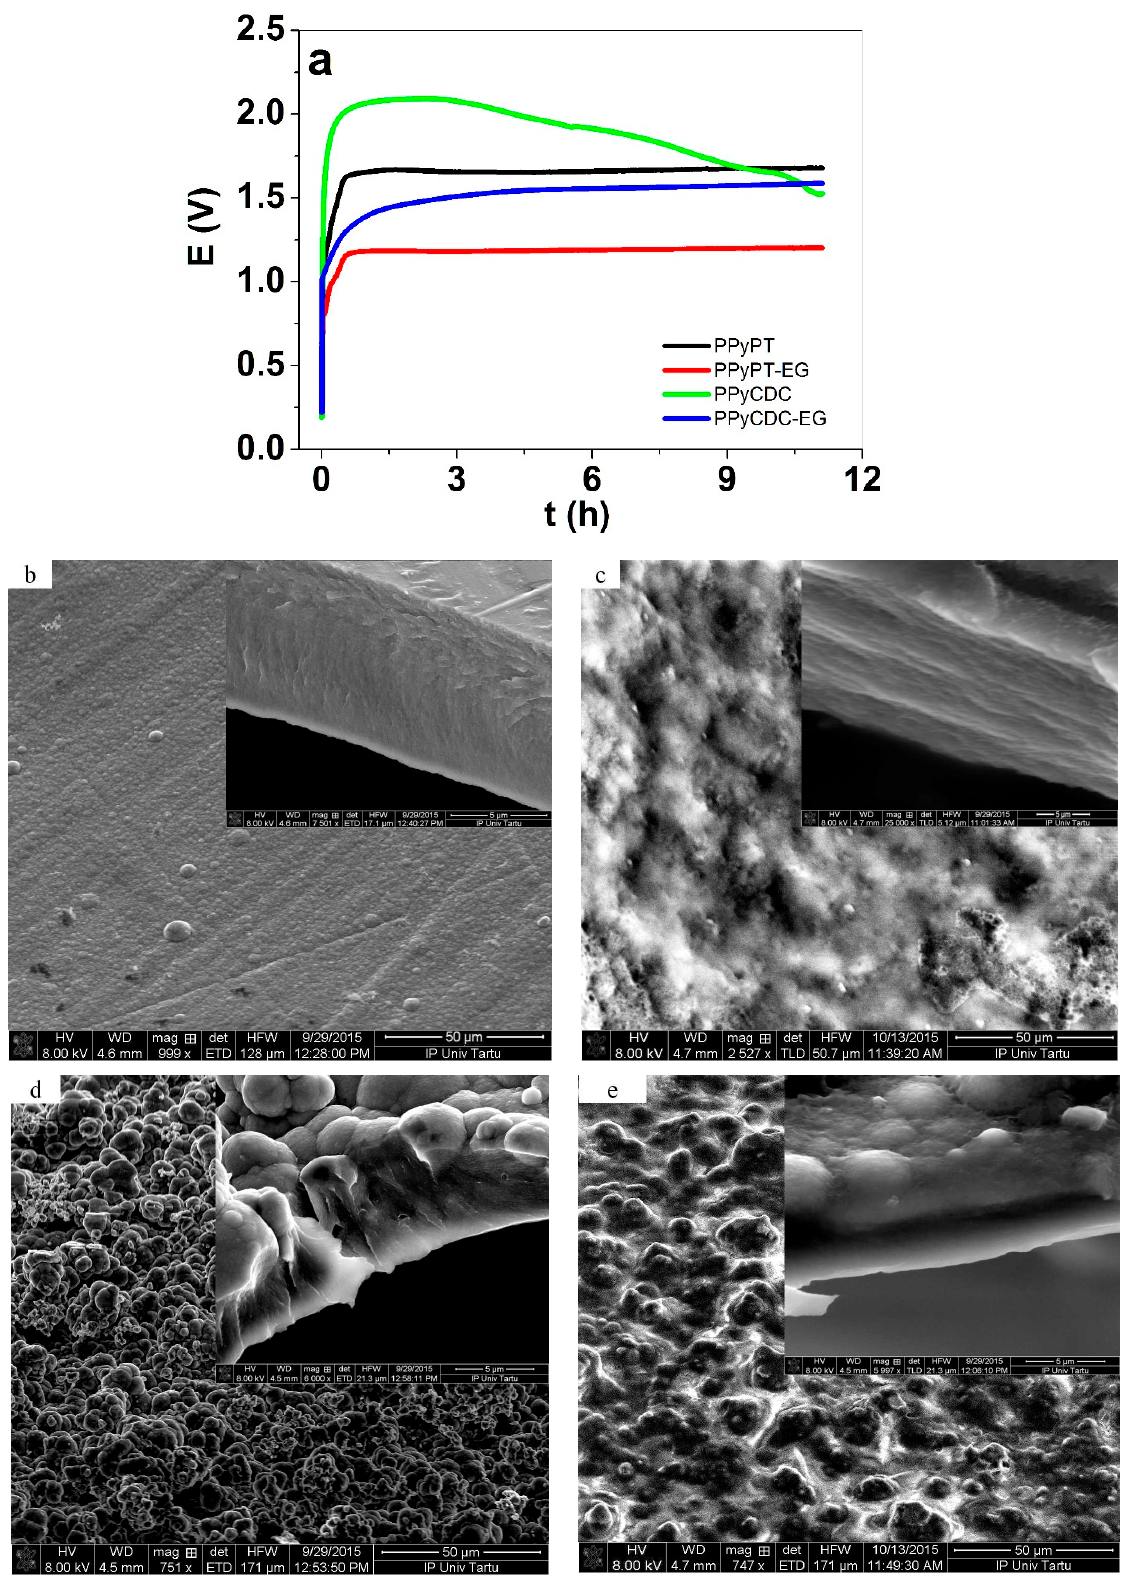
Figure 1. ( a ), Electropolymerization curves are presented of PPyPT (black), PPyPT-EG (red), PPyCDC (green) and PPyCDC- EG (blue). The SEM surface images (scale bar 50 µ m) with insets of cross sections (scale bar 5 µ m) are shown in ( b ), of PPyPT, ( c ), PPyPT-EG, ( d ), PPyCDC and ( e ),